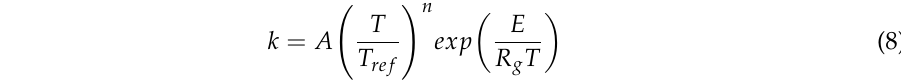
Figure 1. ( a ) Porous domain. ( b ) Fluid domain. ( c ) Solid domain. ( d ) Area exposed to the heat solar flux.